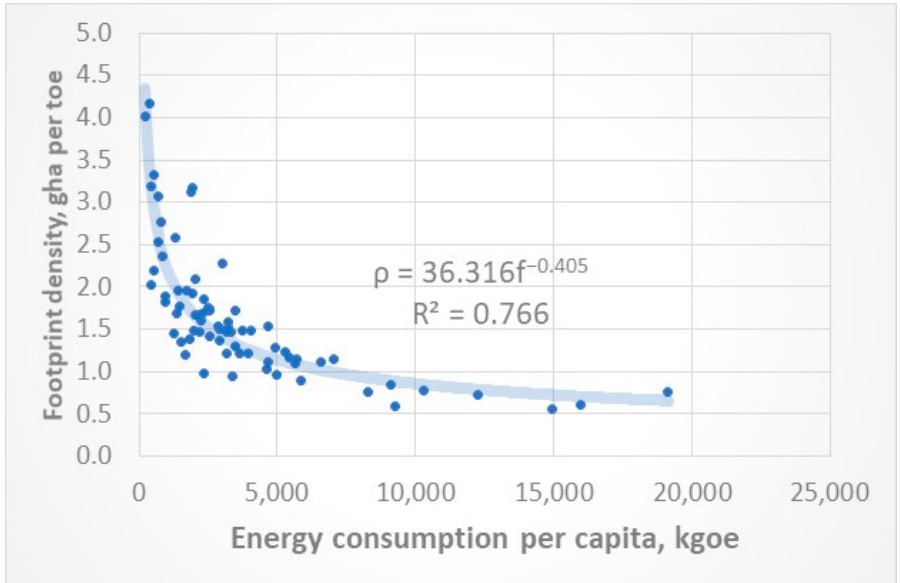
Figure 3. The energy density of ecological footprint and the energy consumption per capita (2016). Source: calculated by the authors based on [49,56,58].